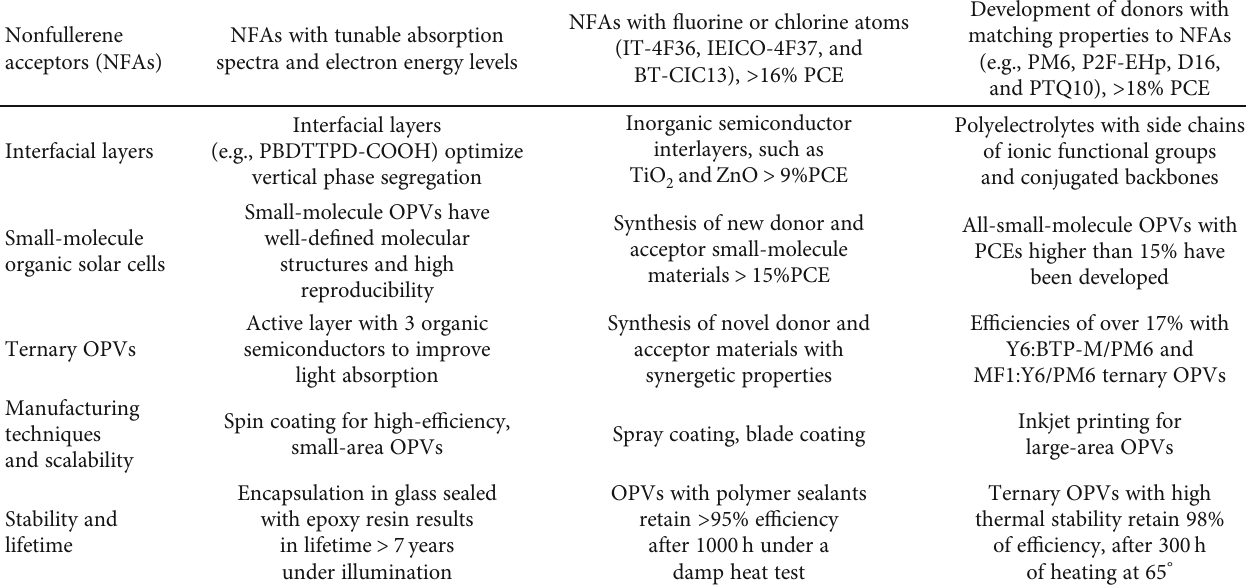
Table 4: Summary of materials, processes, and methods used for the development of state-of-the-art OSCs.